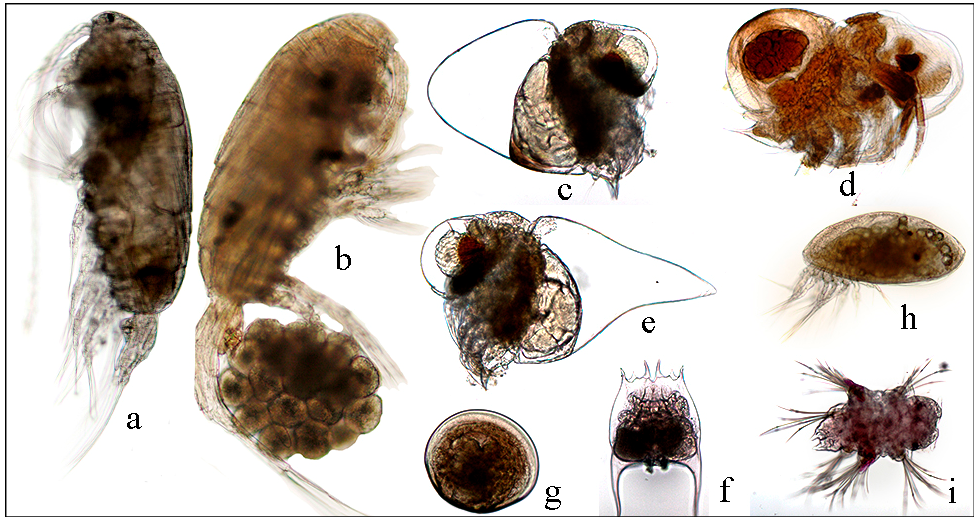
Figure 2. Photos of the dominant species in zooplankton communities in the surveyed waters of the Caspian Sea. Copepods: ( a ) Acartia tonsa , ( b ) Calanipeda aquedulcis; cladocerans: ( c ) Podonevadne trigona , ( d ) Podon intermedius , ( e ) Podonevadne camptonyx; rotifers: ( f ) Brachionus quadridentatus; others: ( g ) larvae of Bivalvia, ( h ) larvae of Cirripedia, ( i ) larvae of Hediste diversicolor.